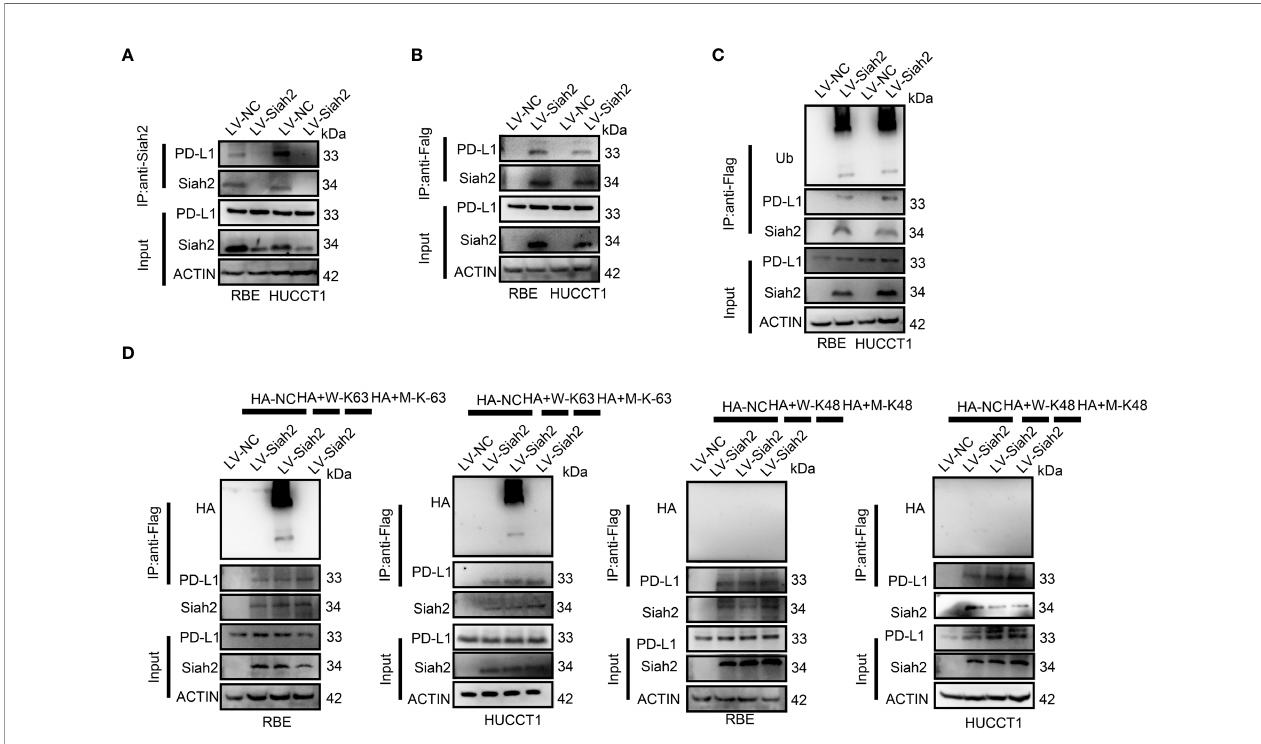
FIGURE 4 | Siah2 physically interacts with PD-L1 and increases the K63-linked ubiquitination of PD-L1 in CCA. (A) , CCA cells were transfected with HA-Siah2 and Flag-PD-L1 for 36 h. Immunoprecipitation was performed with anti-Siah2 and analyzed by immunoblotting. (B) , CCA cells were transfected with HA-Siah2 and Flag- PD-L1 for 36 h. Immunoprecipitation was performed with anti-HA and analyzed by immunoblotting. (C) , CCA cells with LV-NC/LV-Siah2 were treated with MG132 for 8 h before harvesting, after which cells were harvested in lysis buffer. Supernatants were incubated with the appropriate antibodies overnight. Ubiquitin-modi fi ed proteins were analyzed with anti-Ub antibodies. (D) , CCA cells with LV-NC/LV-Siah2 were treated with MG132 for 8 h before harvesting, after which cells were harvested in lysis buffer. Supernatants were incubated with the appropriate antibodies overnight. Ubiquitin-modi fi ed proteins were analyzed with anti-lysine 48(K48) – linked polyubiquitination or K63-linked